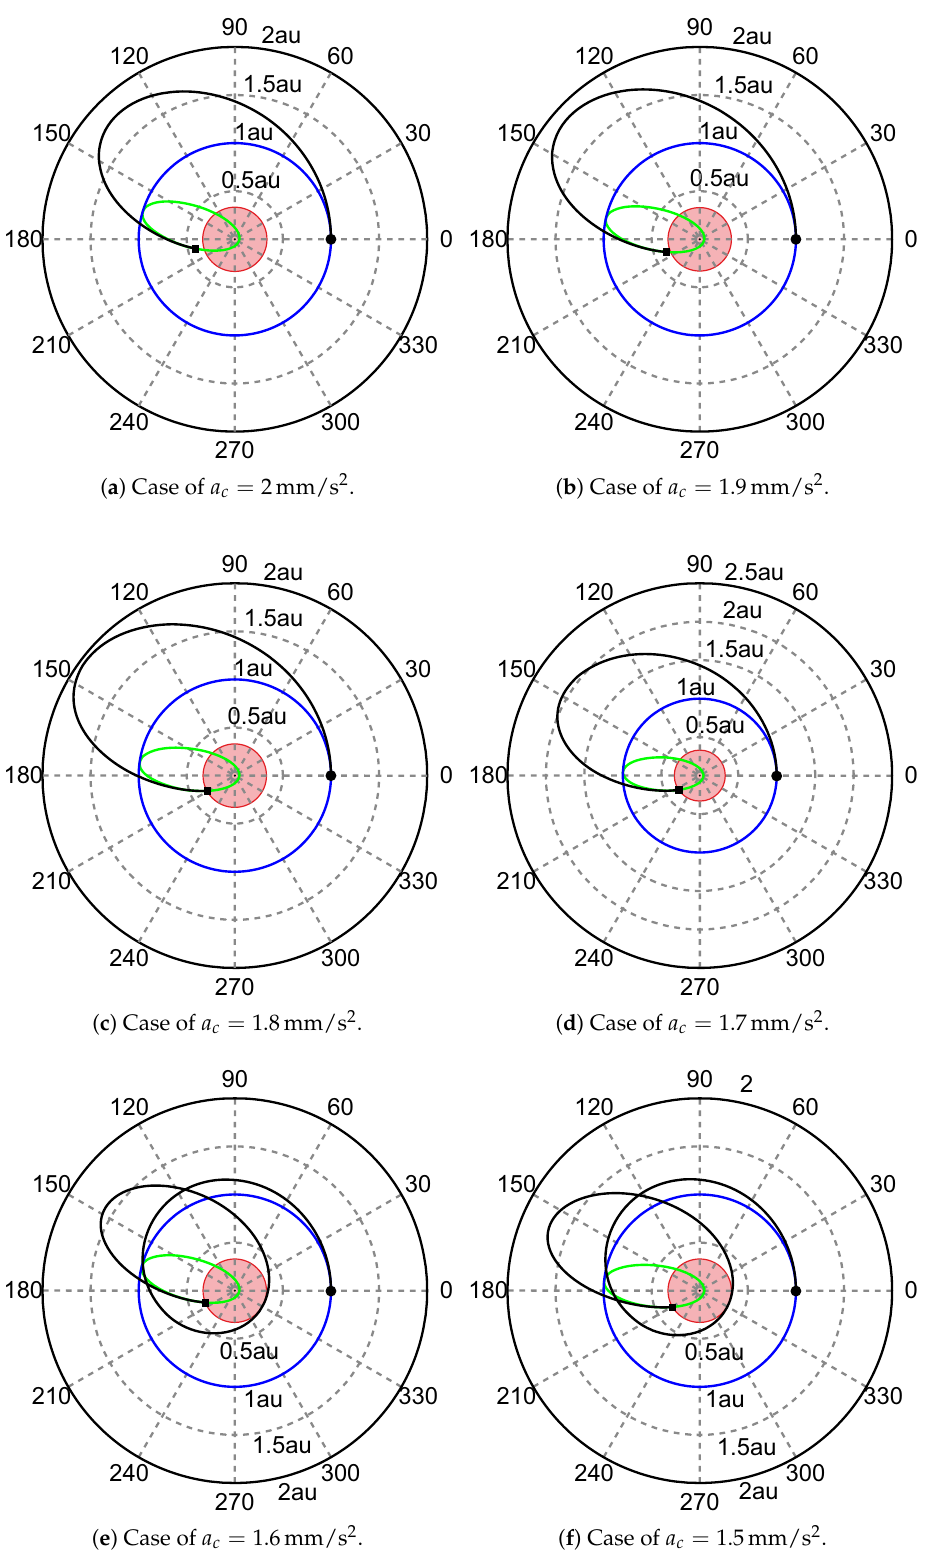
Figure 5. Optimal transfer trajectories as a function of the characteristic acceleration. Blue line → parking orbit; green line → target orbit; black line → transfer trajectory; black circle → starting point; black square → arrival point; filled pink circle → E-sail forbidden